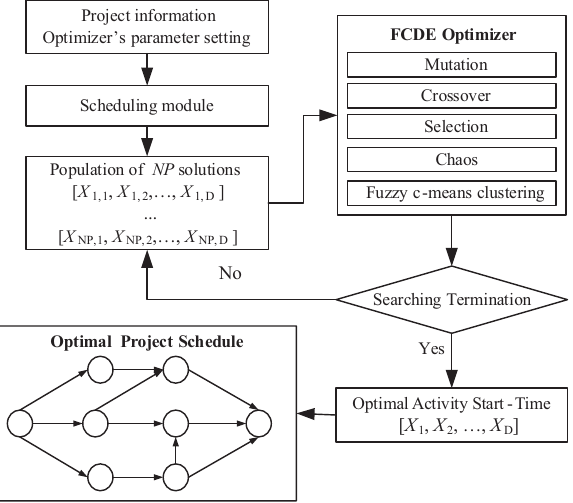
Population of NP solutions [ X 1,1 , X 1,2 ,…, X 1,D